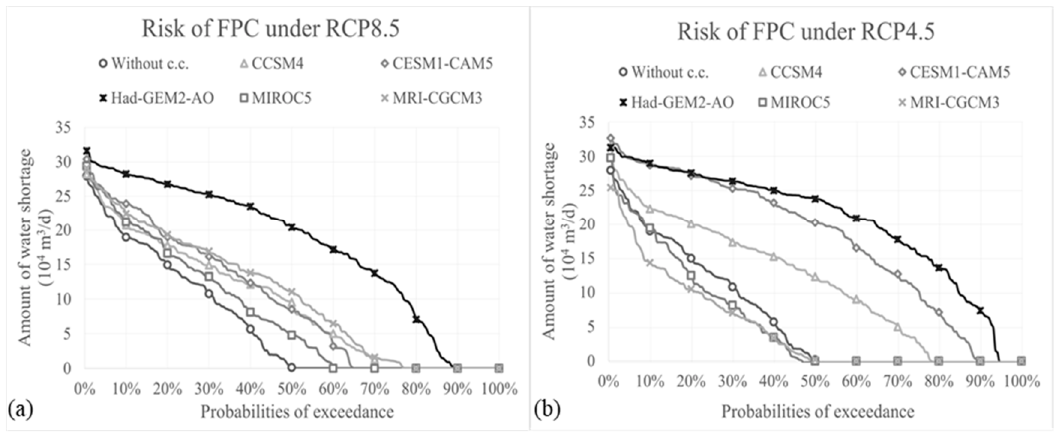
Figure 10. Values of Max. R ( a ), DPD 50 ( b ), MTTR and Max. TTR ( c ), and Availability ( d ) for water shortage of Formosa Plastics Corporation (FPC) in 2021–2040.